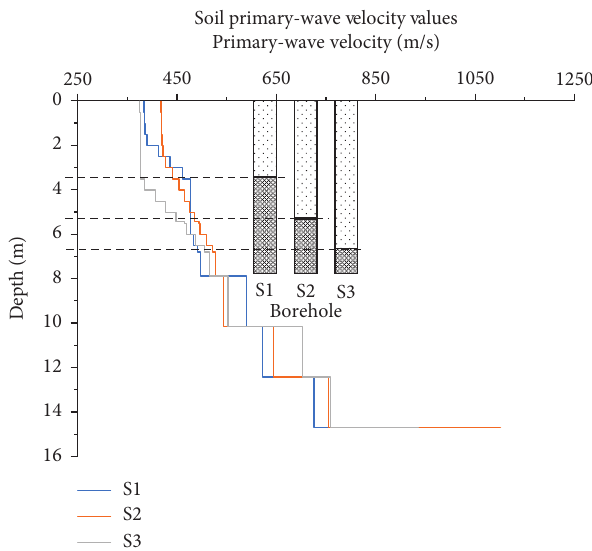
Figure 12: 1D V p values compared with borehole